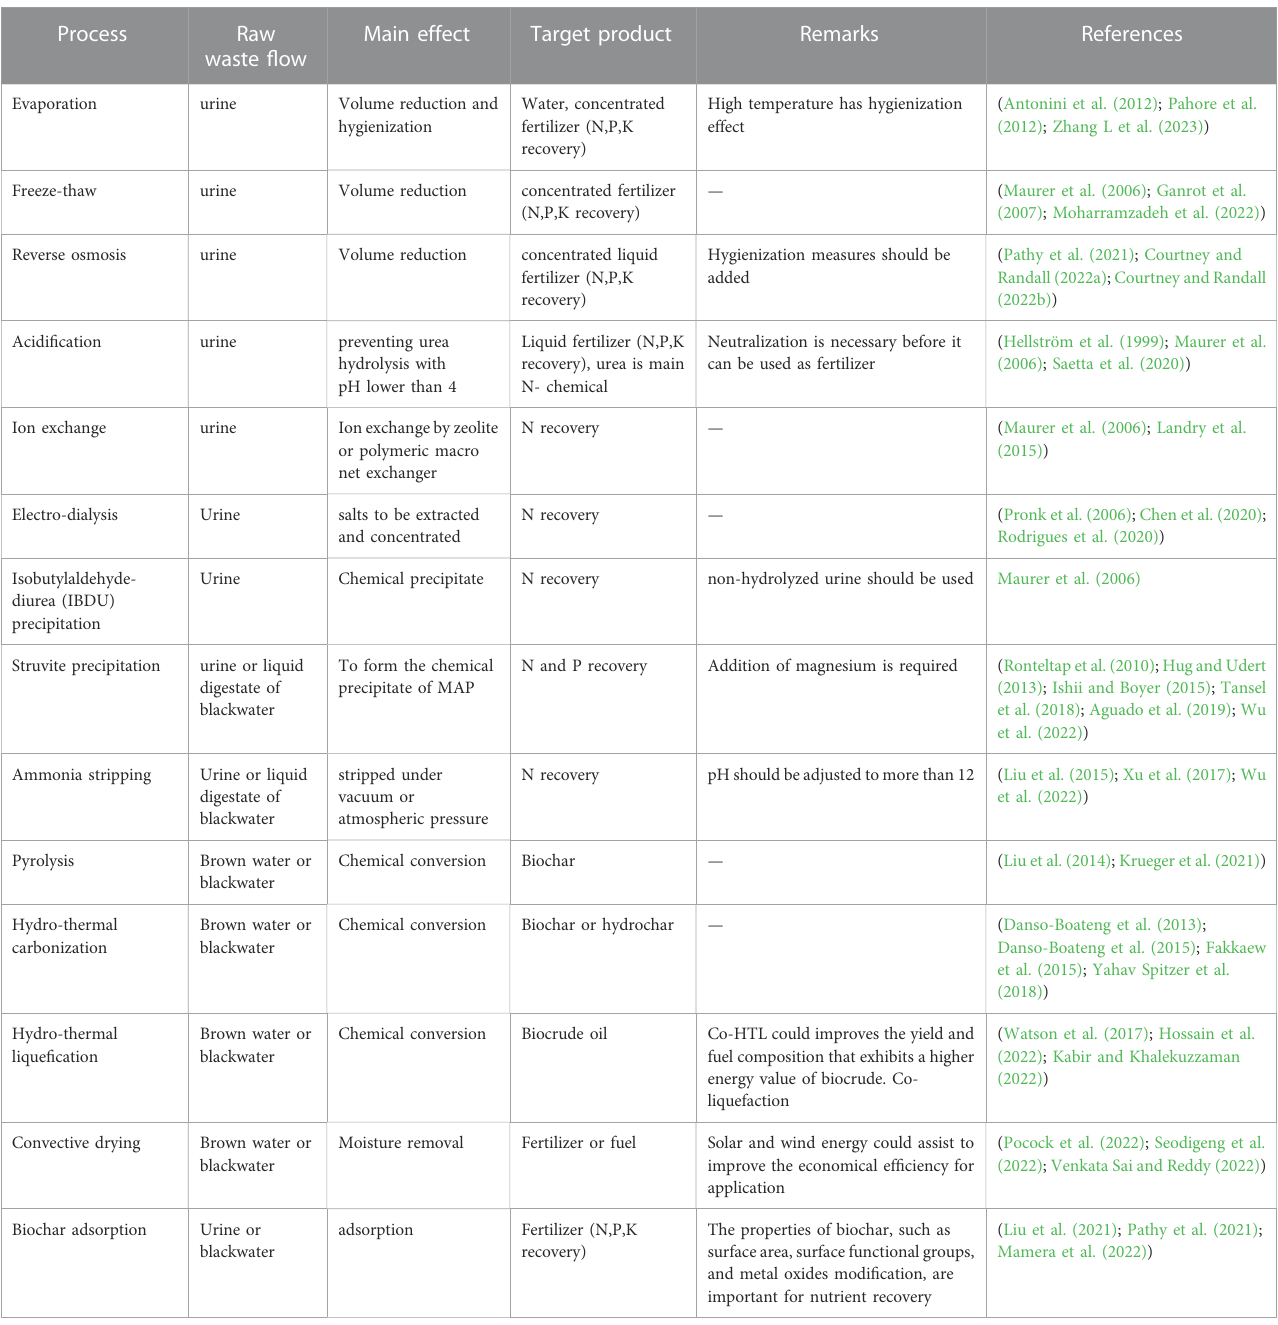
TABLE 4 Physicochemical processes for blackwater